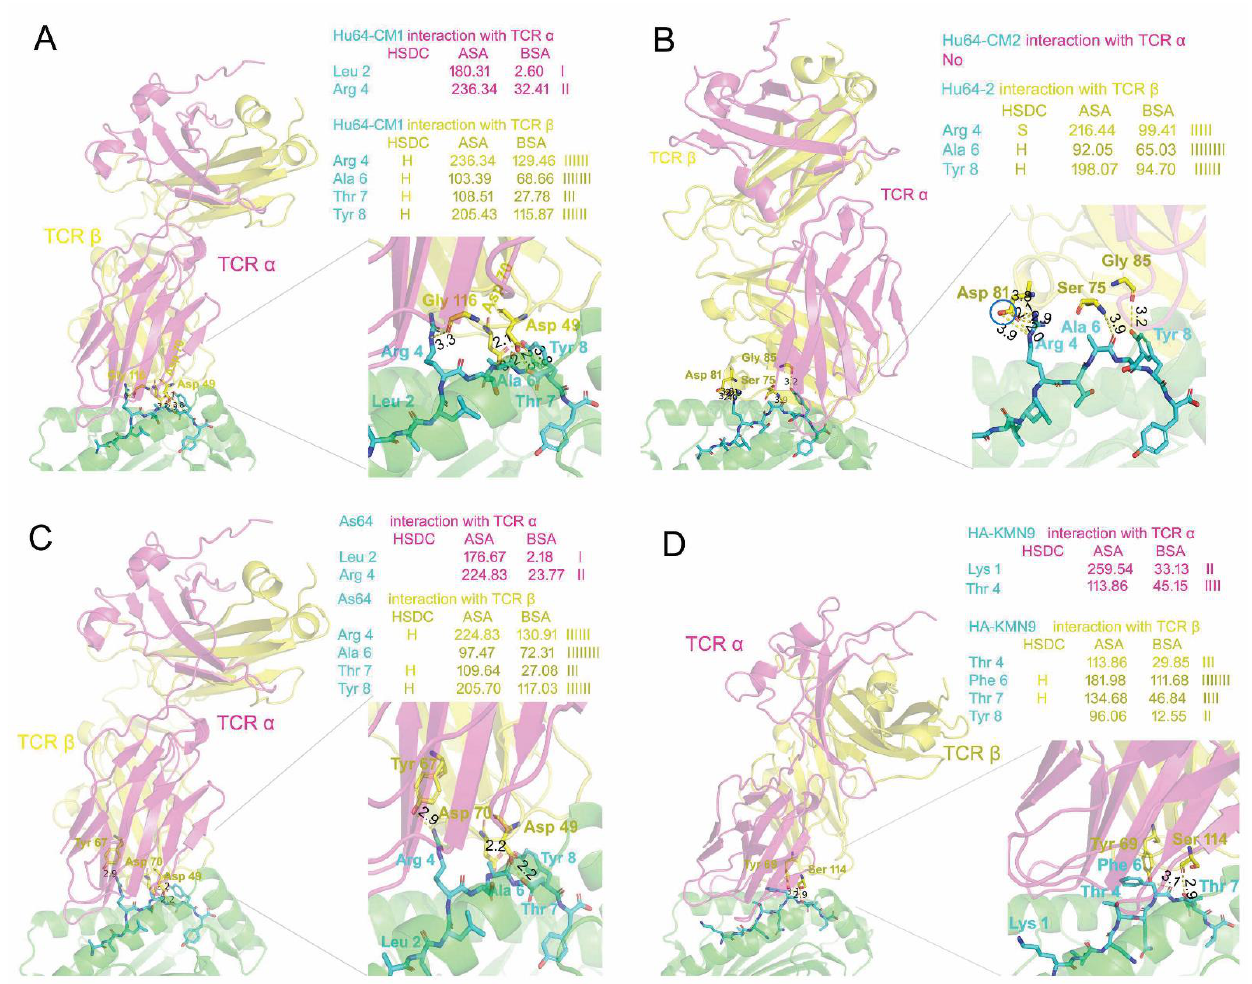
Figure 5. Comparing the conformation of the flexible TCR contact region with different SLA-I molecules. ( A ) The flexible TCR (swine TCR α and β homology modeling based on [54] 1nfd.2.A and 5sws.1.D) contact region with SLA-2*HB01–Hu64-CM1. ( B ) The flexible TCR (swine TCR α and β homology modeling based on 1nfd.2.A and 5swz.3.D) contact region with SLA-2*HB01–Hu64-CM2. The blue circle indicates the carboxyl of Asp 81 in the TCR β chain involved in formation of a salt bridge between Asp 81 in TCR β and Arg 4 in peptide Hu64. ( C ) The flexible TCR (swine TCR α and β homology modeling based on 1nfd.2.A and 5swz.3.D) contact region with SLA-2*HB01–As64. ( D ) The flexible TCR (swine TCR α and β homology modeling based on 1nfd.2. α and 5swz.3.D) contact region with SLA-3*hs0202–HA kmN9. From A to D, the TCR α and β are shown as cartoon models in light magenta and yellow, respectively, whereas the heavy chain of SLA class I complexed